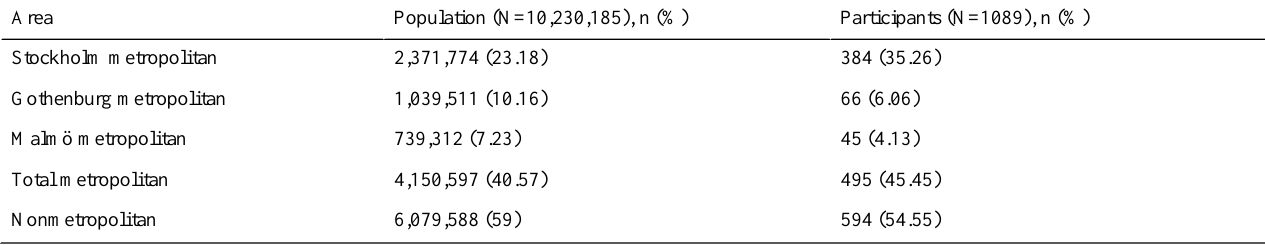
Table 1. Geographical distributions of the Swedish population and study